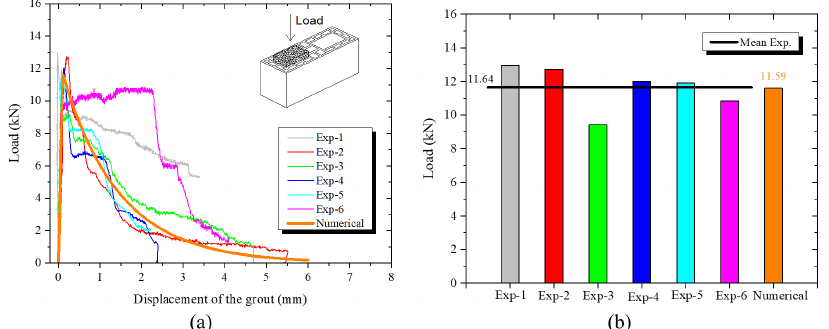
Figure 9. Validation of numerical results of the ClG14 series of push-out tests: (a) force vs displacement diagrams and (b) mean maximum